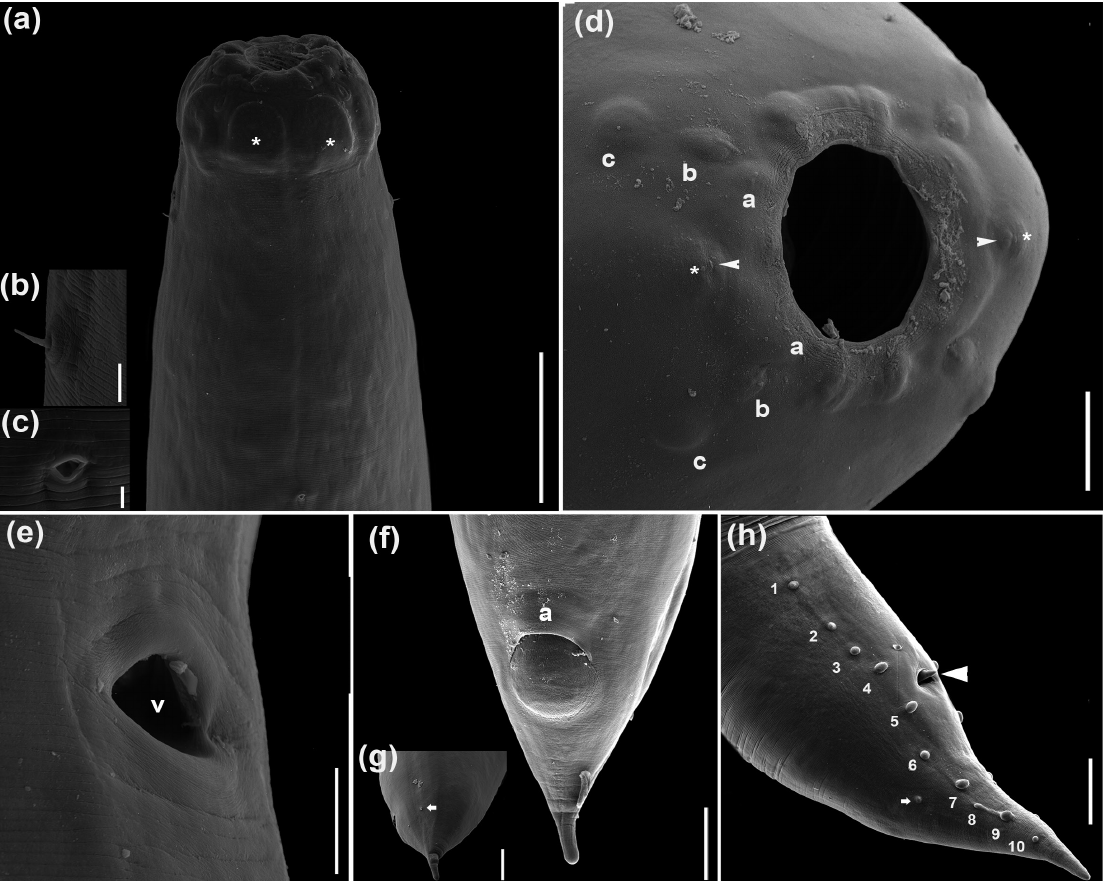
Figure 1. Scanning electron microscopy of Spirocamallanus krameri : (a ) Cephalic region view: mouth aperture and buccal capsule internally sustained by 8 elongated internal supports (*), deirids and excretory pore. Scale bars = 100 µm. (b ) Detail of deirids. Scale bars = 5 µm. (c) Detail of excretory pore and finely and transversely striated cuticle. Scale bars = 2 µm. (d) Mouth aperture hexagonal, cephalic papilla (a,b,c), amphidial papillae (*) and amphid (arrowhead). Scale bars = 20 µm. (e ) Vulva (v), vulval lips not elevated. Scale bars = 10 μm. (f) Female tail, anus (a). Scale bars = 50 μm. (g) Detail of lateral phasmidial pores (arrowhead). Scale bars = 50 μm. (h) Tail of male, ventral- lateral views; cloacal opening, spicule (arrowhead), four Precloacal papillae, six postcloacal papillae and lateral phasmidial pores (arrowhead). Scale bars = 50